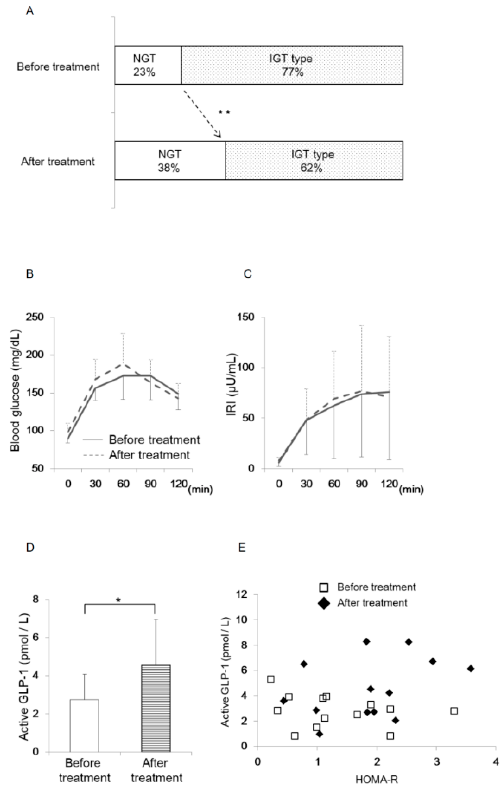
Figure 7. Glucose homeostasis in PA patients before and after eplerenone treatment ( n = 13). ( A ) Results of oral glucose tolerance test (OGTT) before and after eplerenone treatment in PA patients (Chi-square test, ** p < 0.01). NGT: normal glucose tolerance. IGT: impaired glucose tolerance. ( B ) Blood glucose concentration before and after eplerenone treatment during OGTT. ( C ) Immunoreactive insulin (IRI) concentration before and after eplerenone treatment during OGTT. ( D ) Active GLP-1 concentration at 60 min during OGTT before and after eplerenone treatment (paired t-test, * p < 0.05). ( E ) Active GLP-1 concentration and HOMA-R per patient. Data are shown as mean ±